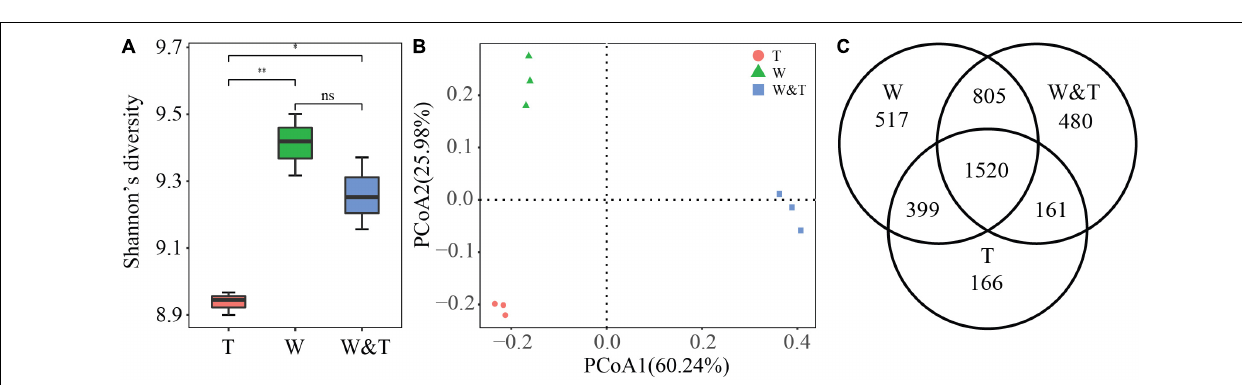
FIGURE 3 | Bacterial community α -diversity and β -diversity. (A) Shannon’s diversity for bacterial communities in monoculture tea forest (T), monoculture walnut forest (W), and walnut–tea intercropping forest (W&T). A box indicates the interquartile range; a black line indicates the median value. A lowercase letter on each box represents a least significant difference (LSD; p < 0.05) between the T, W, and T&W. Asterisks indicates significant differences ( ∗ p < 0.05, ∗∗ p < 0.01). (B) Principal coordinate analysis (PCoA) plots based on the Bray–Curtis distance demonstrating the separation between soil bacterial communities of three forest types. (C) The Venn diagram shows the numbers of bacterial operational taxonomic units (OTUs) that are shared or unshared by T, W, and